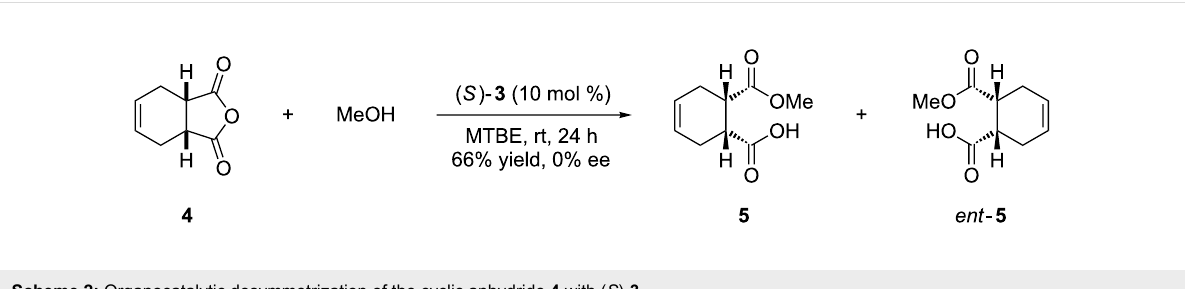
Scheme 2: Organocatalytic desymmetrization of the cyclic anhydride 4 with ( S )- 3